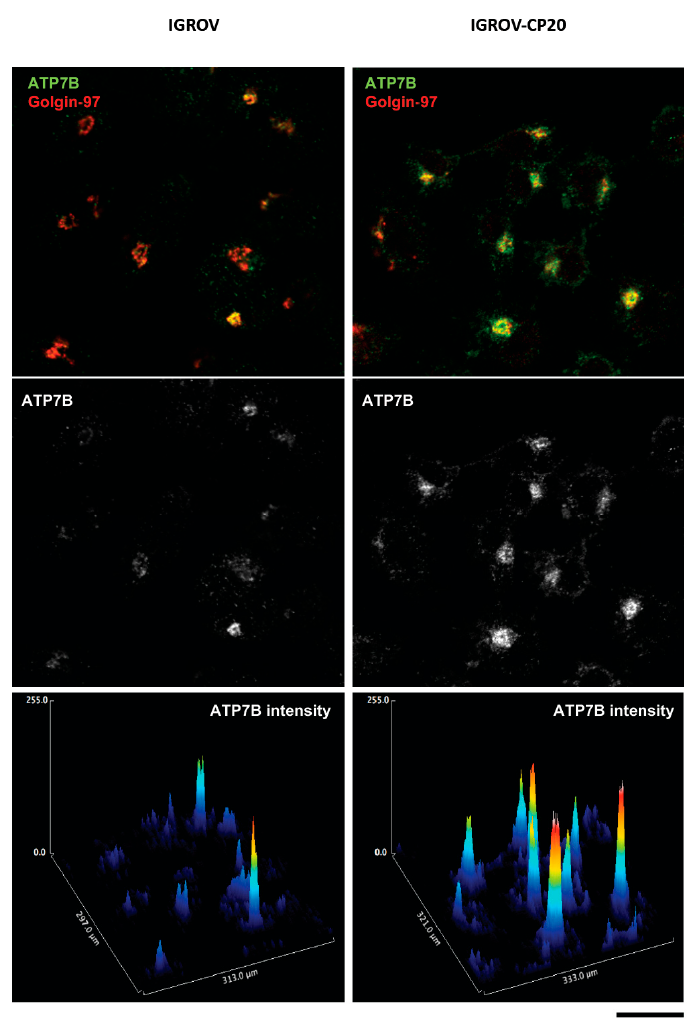
Figure 3. Expression of ATP7B in cisplatin-resistant and cisplatin-sensitive ovarian cancer cells. Pt-sensitive (IGROV) and Pt-resistant (IGROV-CP20) ovarian cancer cells were labeled for endogenous ATP7B and TGN resident protein Golgin-97 and then visualized using confocal microscopy. Graphs (bottom row) show intensities of ATP7B signal in corresponding images. Pt-resistant IGROV-CP20 cells exhibit higher levels of ATP7B compared to parental Pt-sensitive IGROV line. Scale bar: 25 µm.